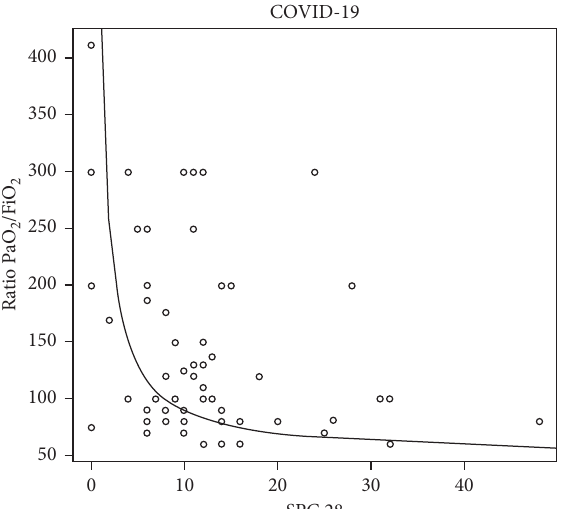
Figure 5: Demonstrates for COVID-19 patients, an inverse relationship between subpleural consolidation (SPC) and the Ratio PaO